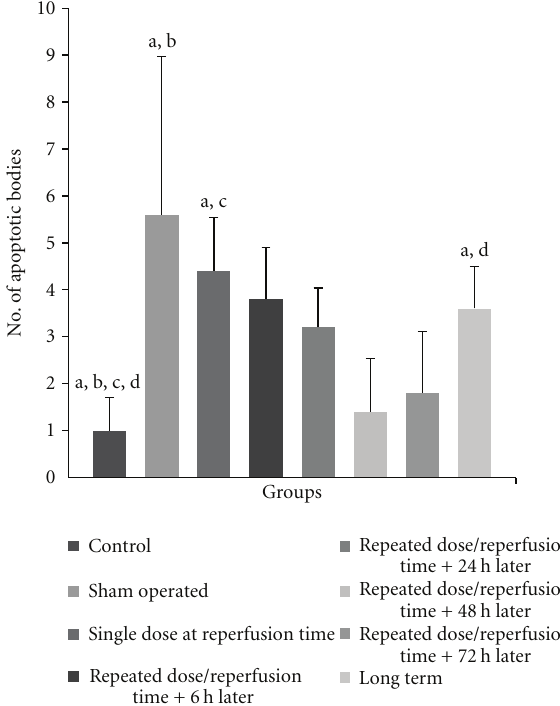
Figure 4: Bar graph shows the e ff ect of repeated doses of FK506 on ischemia-induced, hippocampal pyramidal CA1 cell death (apoptotic body) in various times of injection. a,b,c P < 0 . 05 control versus sham, single dose and long term